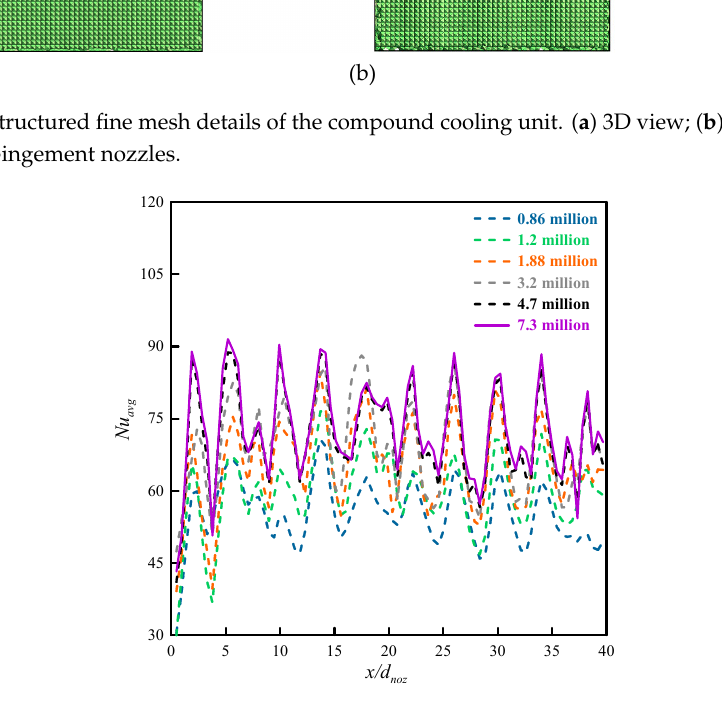
Figure 8. Streamwise-averaged Nusselt number distribution on the target surface for six different meshes. Table 1. Overall Nusselt number at Re noz = 15,000 for different meshes. Mesh (million)